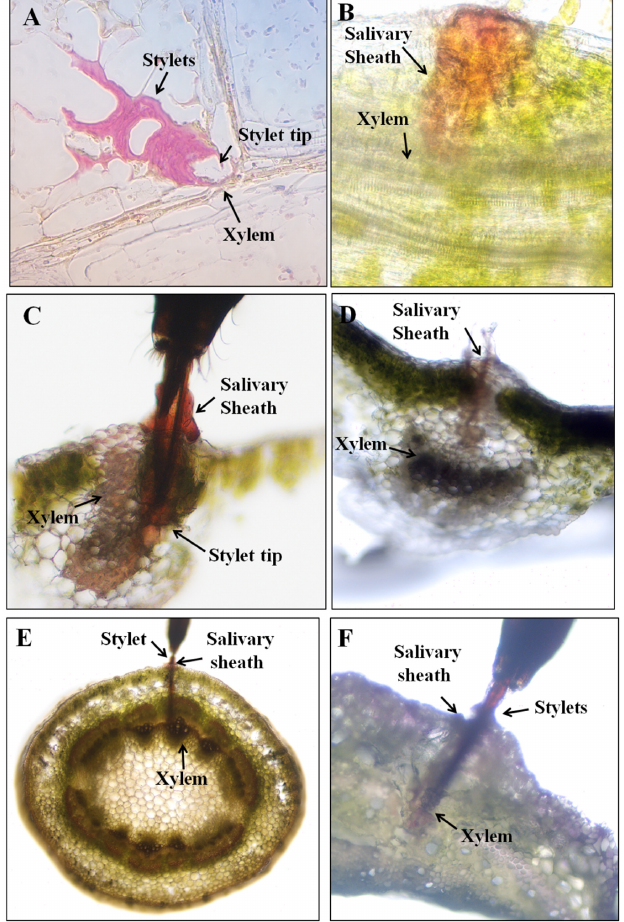
Figure 6. Cross sections of soybean leaflets and stems containing severed stylets and/or salivary sheath of R. pedestris during waveform Rp2. ( A ) Complete stylet tips ending in the xylem vessels of leaflet during waveform Rp2 (Paraffin section). ( B , D ) Complete salivary sheath ending in the xylem vessels of leaflet during waveform Rp2. ( C , D ). Complete stylet tips ending in the xylem vessels of leaflet during waveform Rp2. Salivary sheath was stained with acid fuchsine. ( E ) Salivary sheath stained with acid fuchsine in the stem tissue. ( F ) Stylets and secreted salivary sheath ending in the xylem vessel.